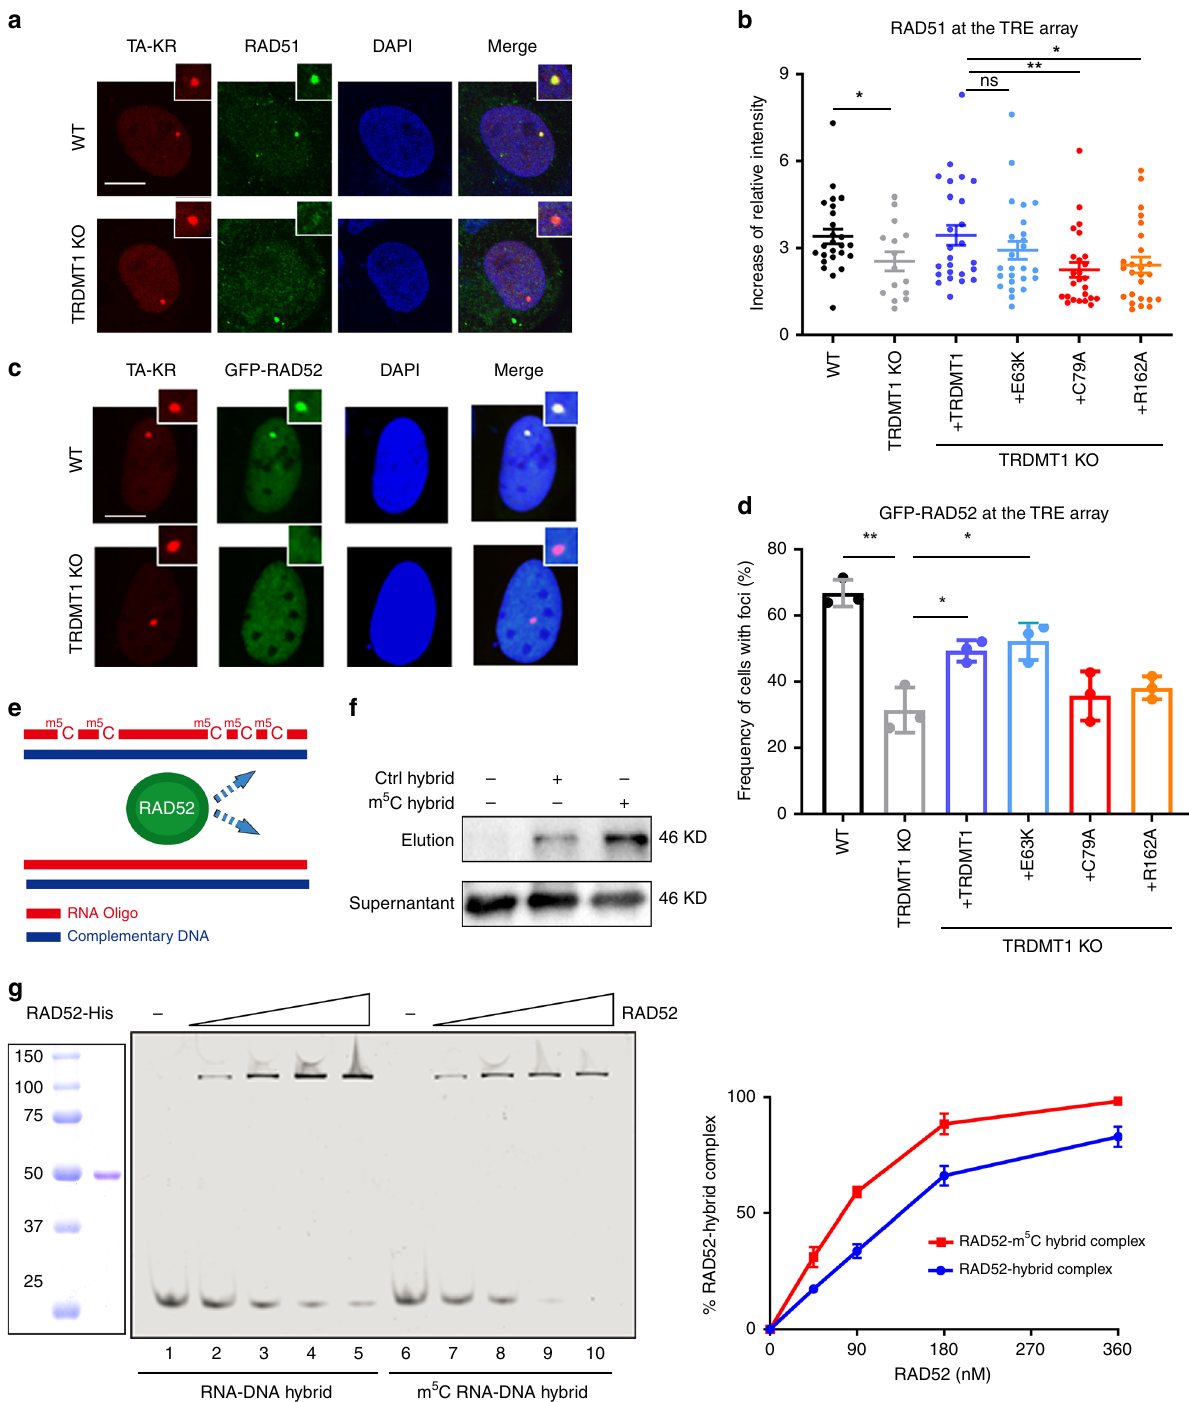
Fig. 4 RAD52 is a m 5 C reader. a U2OS-TRE WT and TRDMT1 KO cells were transfected with TA-KR and stained for RAD51 1 h after light irradiation. Representative fi gures were shown (scale bar: 10 μ m). b U2OS-TRE WT, TRDMT1 KO, and TRDMT1 stably rescued cell lines were transfected with TA-KR. and stained for RAD51 1 h after light irradiation. Fold increase of RAD51 foci intensity was calculated ( n = 25, mean ± SD). c U2OS-TRE WT and TRDMT1 KO cells were transfected with TA-KR and GFP-RAD52 and fi xed 1 h after light irradiation. Representative fi gures were shown (scale bar: 10 μ m). d U2OS- TRE WT, TRDMT1 KO, and TRDMT1 stably rescued cell lines were co-transfected with GFP-RAD52 and TA-KR and quanti fi ed for RAD52 foci frequency ( n = 3, mean ± SD). e RNA oligos with or without m 5 C modi fi cation and their complementary DNA oligos were chemically synthesized for RAD52 binding experiments. f RAD52 protein in the cell lysate was pulled down by biotin-labeled DNA:RNA hybrids, with or without m 5 C RNA modi fi cation, coated on streptavidin magnetic beads. g The binding of RAD52 protein to DNA:RNA hybrids with or without m 5 C RNA modi fi cation was measured in electrophoretic mobility shift assays and quanti fi ed ( n = 3, mean ± SD). Statistical analysis was performed with the unpaired two tailed Student ’ s t- test. * p < 0.05; ** p < 0.01; *** p < 0.001; **** p <